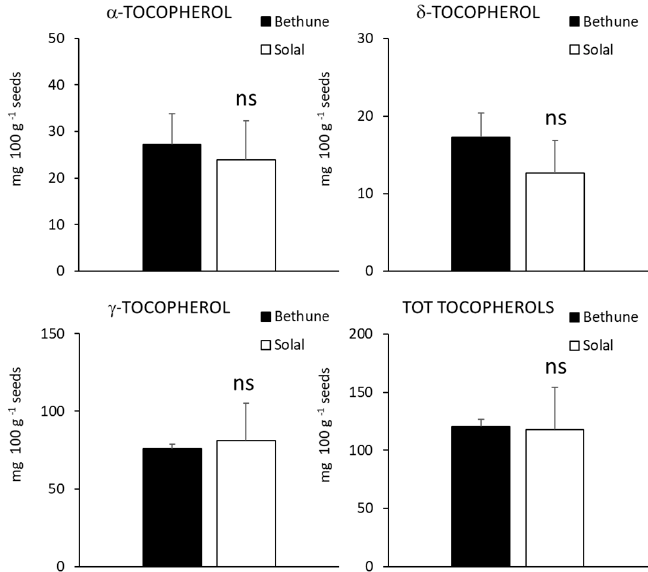
Figure 4. Concentration (mg 100 g − 1 seeds) of α -, δ -, γ - and total tocopherols of the two linseed varieties (Bethune and Solal). n.s. = not significant.